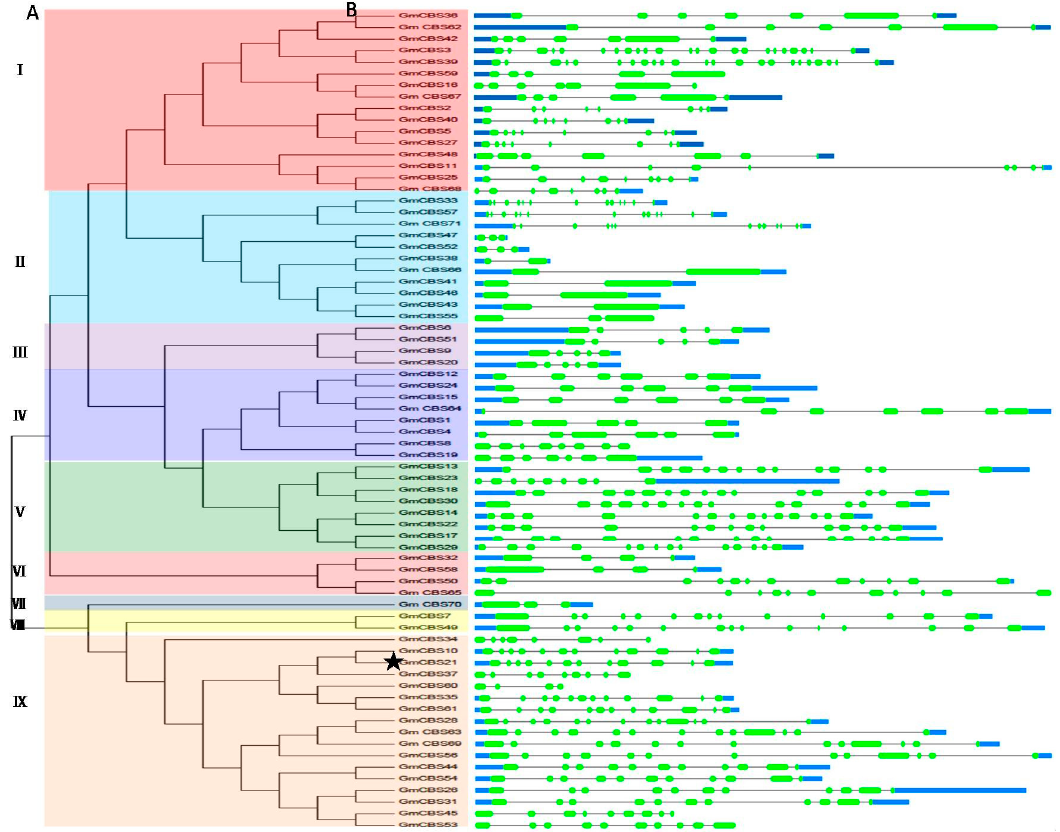
Figure 1. Phylogenetic analysis and structure of soybean CBS genes. ( A ) Phylogenetic tree construction of soybean CBS genes based on the full-length deduced amino acid sequences using MEGA 5.0 (Koichiro Tamura, Daniel Peterson, Nicholas Peterson, Glen Stecher, Masatoshi Nei, and Sudhir Kumar) by the maximum likelihood method with 500 bootstrap replicates. The tree showed nine major phylogenetic groups (group I to IX) indicated by different colored background. The star marked our candidate gene GmCBS21 ; ( B ) Exon/intron structures of GmCBS genes. Green boxes represent exons, black lines indicate introns, and blue boxes represent untranslated region (UTR). The members within each group showed similar exon/intron structures. Group I comprised 16 members, and most of them are voltage-gated chloride channel proteins except GmCBS2 , GmCBS40 ,